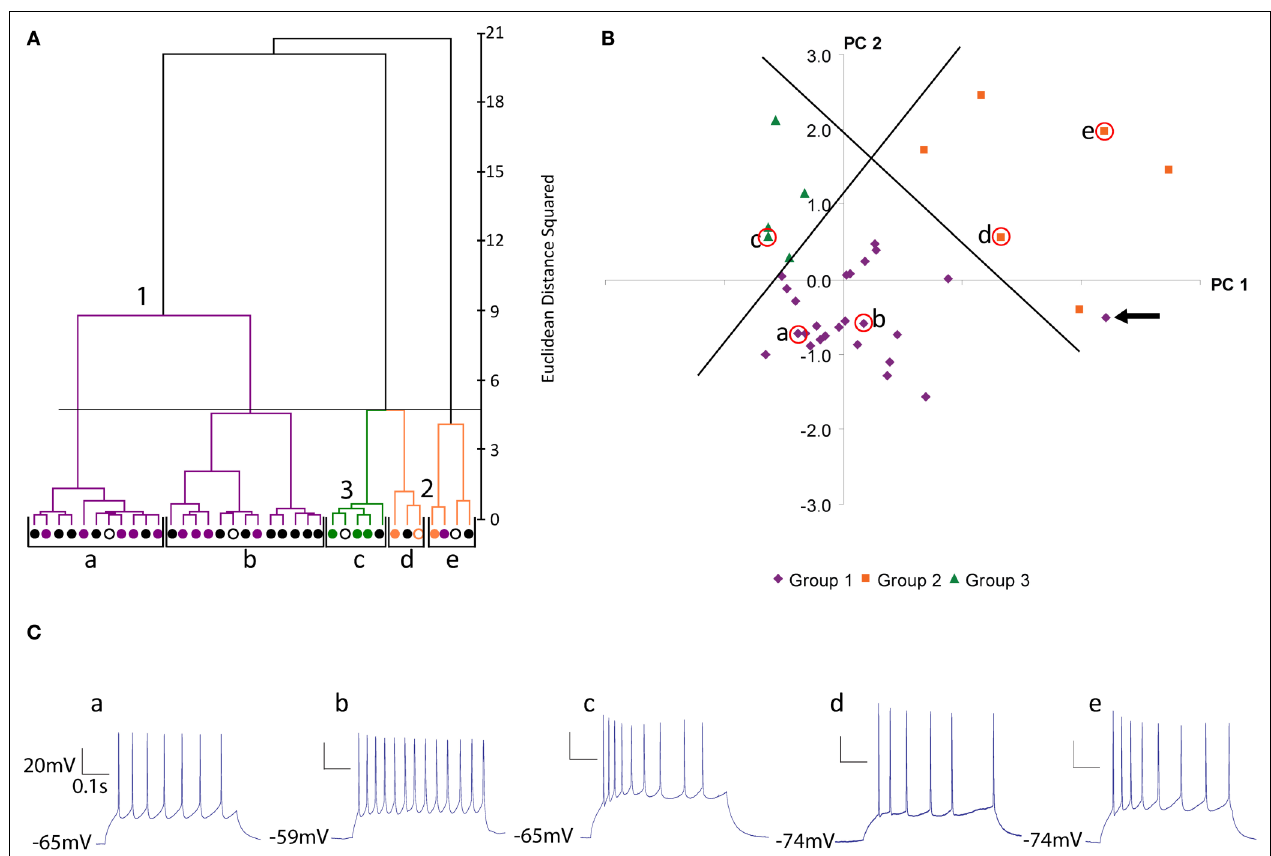
This color scheme is based on the clustering by morphological variables (See Figure 1 ) and will be preserved for all fi gures. Black cells are those without morphological reconstruction. (B) Scatterplot of dataset in principal component space. The x -axis represents the fi rst principal component (PC1) and the y -axis represents the second principal component. Centroids of clusters are labeled and circled in red. Orthogonal lines separating the three groups are shown. The outlier in cluster e is indicated with an arrow. (PC2). (C) Current clamp recording of response to twice threshold current pulse for the centroid cells of each